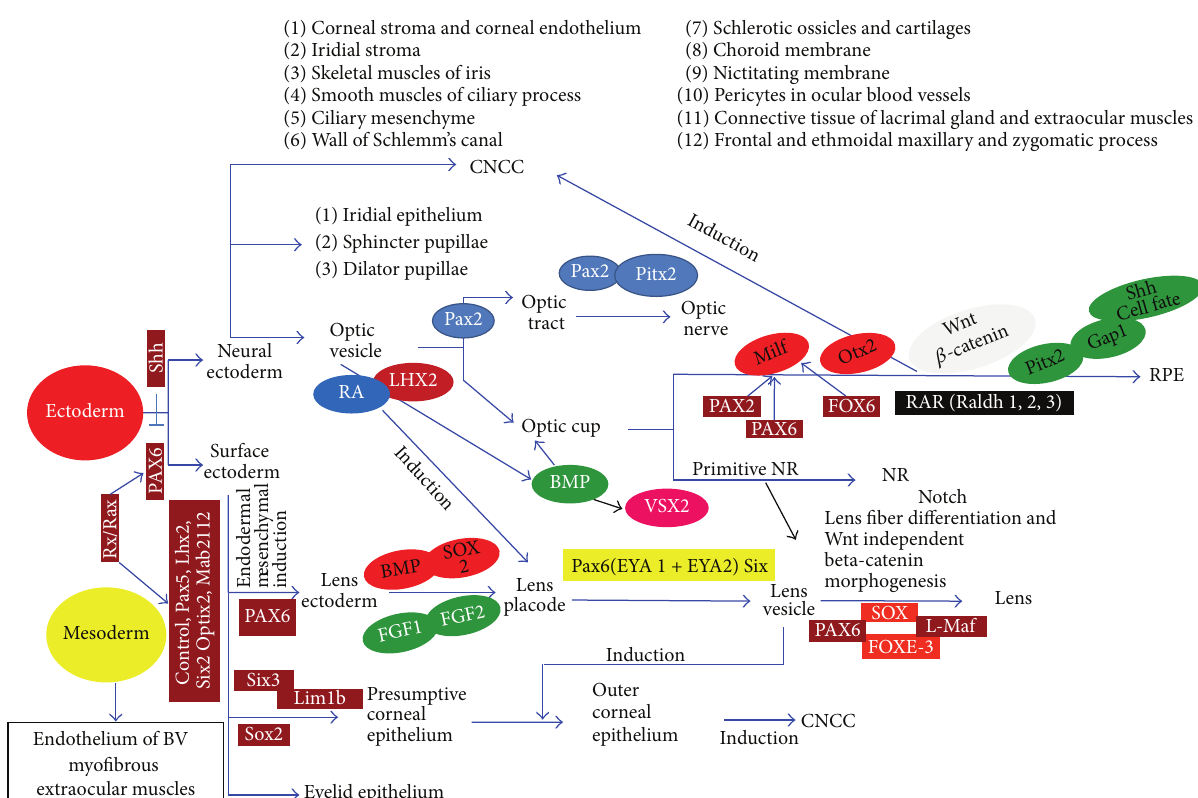
Figure 3: Flow chart: major events of eye development and the involvement of biomolecules. Copyright 2009. Modified with permission from Mosby/Elsevier Ltd.